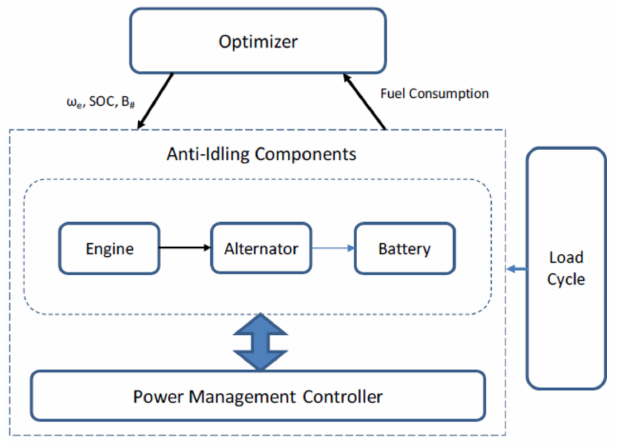
Figure 24. Case study two for the proposed optimizer